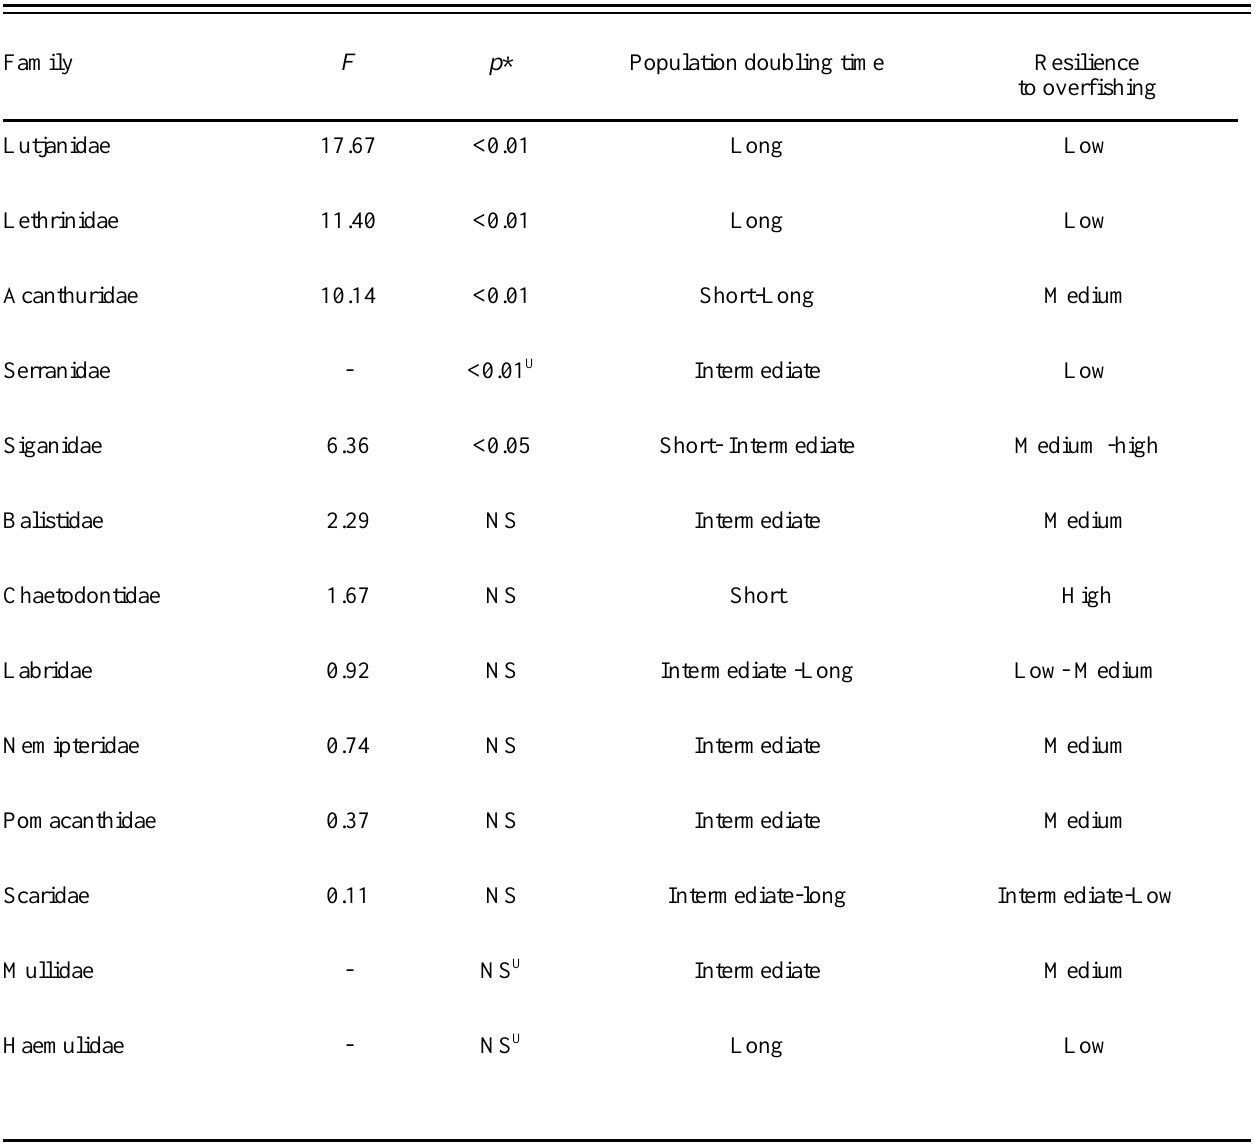
Table 2. Muluk: Results of the one-way ANOVAs for comparisons of biomass, inside vs. outside closures, and a summary of life histories and resilience to overfishing. Adapted from Froese and Pauly (1995) for families commonly caught in subsistence Indo-Pacific